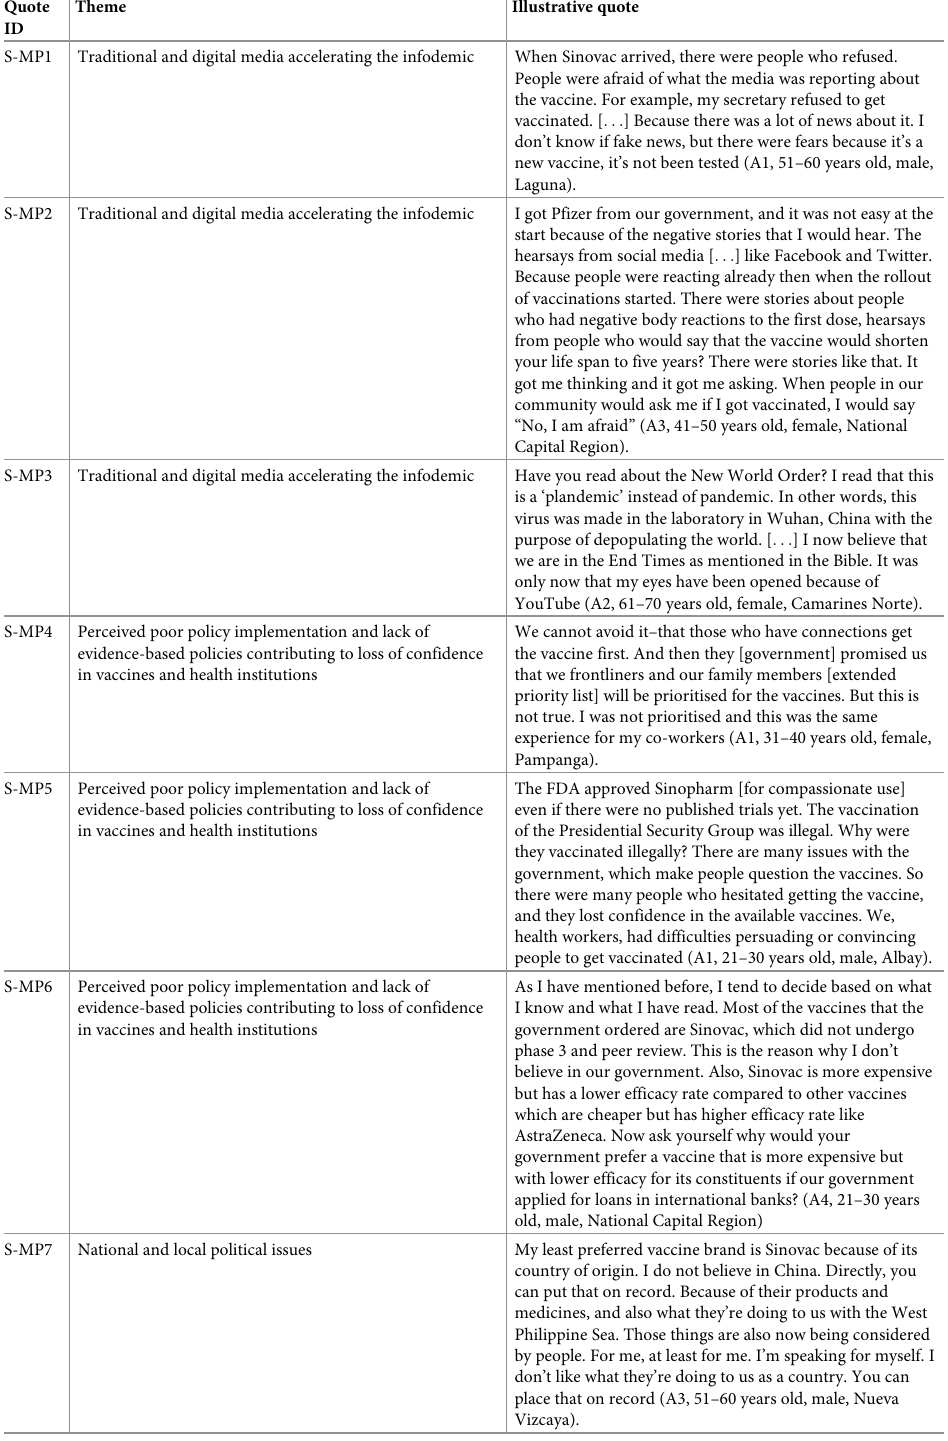
Table 6. Illustrative quotes for structural barriers relating to the media and